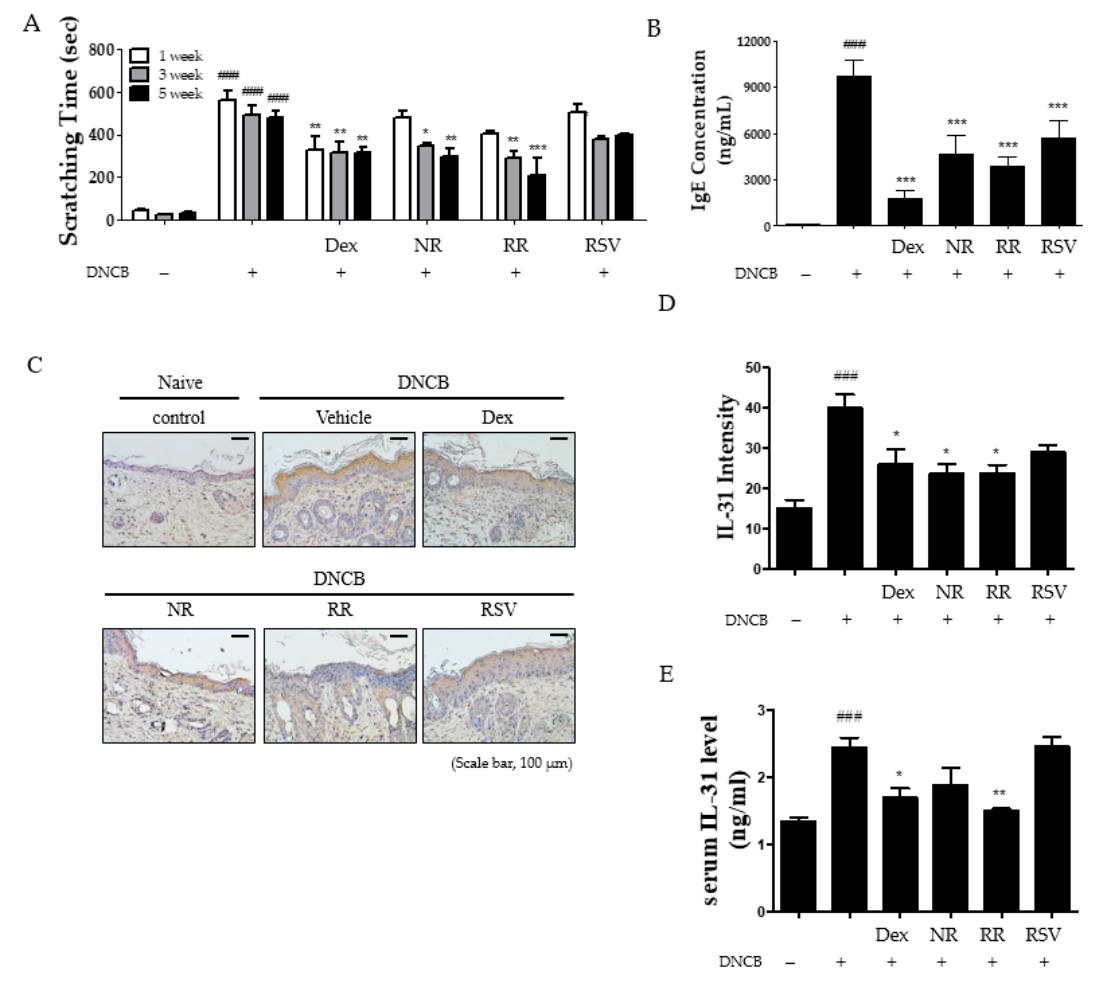
Figure 2. Effect of RR on pruritus in DNCB-induced NC/Nga mice. ( A ) Scratching frequency was measured via videotaping mice from above for 20 min. ( B ) The level of serum IgE was measured using ELISA. ( C ) Expression of IL-31 in DNCB-induced NC/Nga mice was measured using IHC. Scale bar, 100 µ m. ( D ) Graphical representation of expression of IL-31 in dorsal skin. ( E ) The level of serum IL-31 was measured using ELISA. Values are expressed as means ± SEM. ### p < 0.001 versus vehicle group; * p < 0.05, ** p < 0.01, and *** p < 0.001 versus DNCB-treated group.